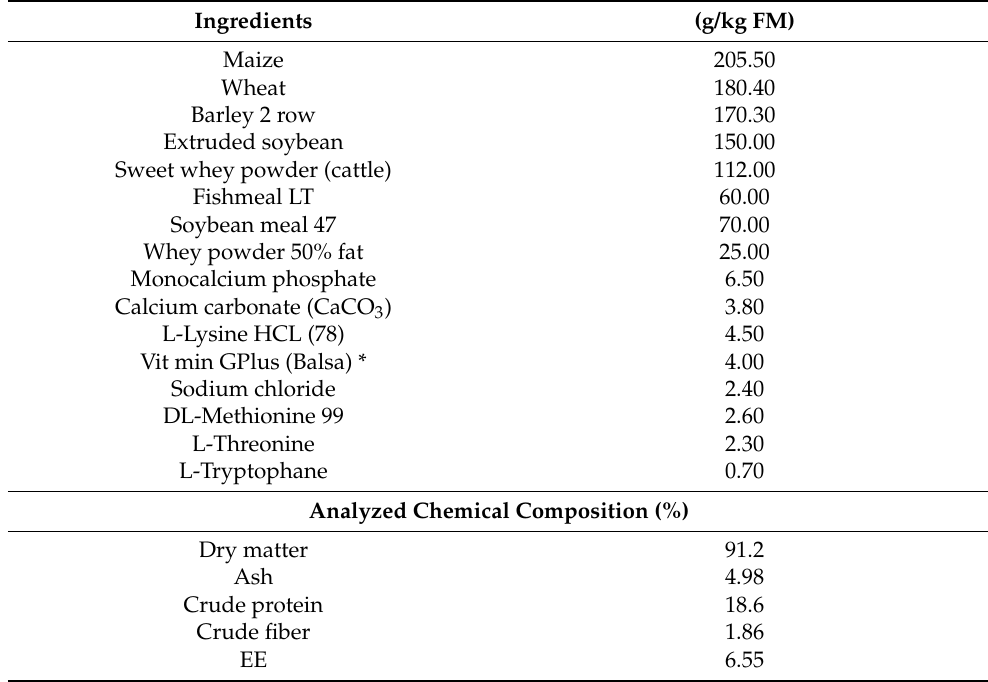
Table 1. Ingredients and analyzed composition of basal diet (g/kg